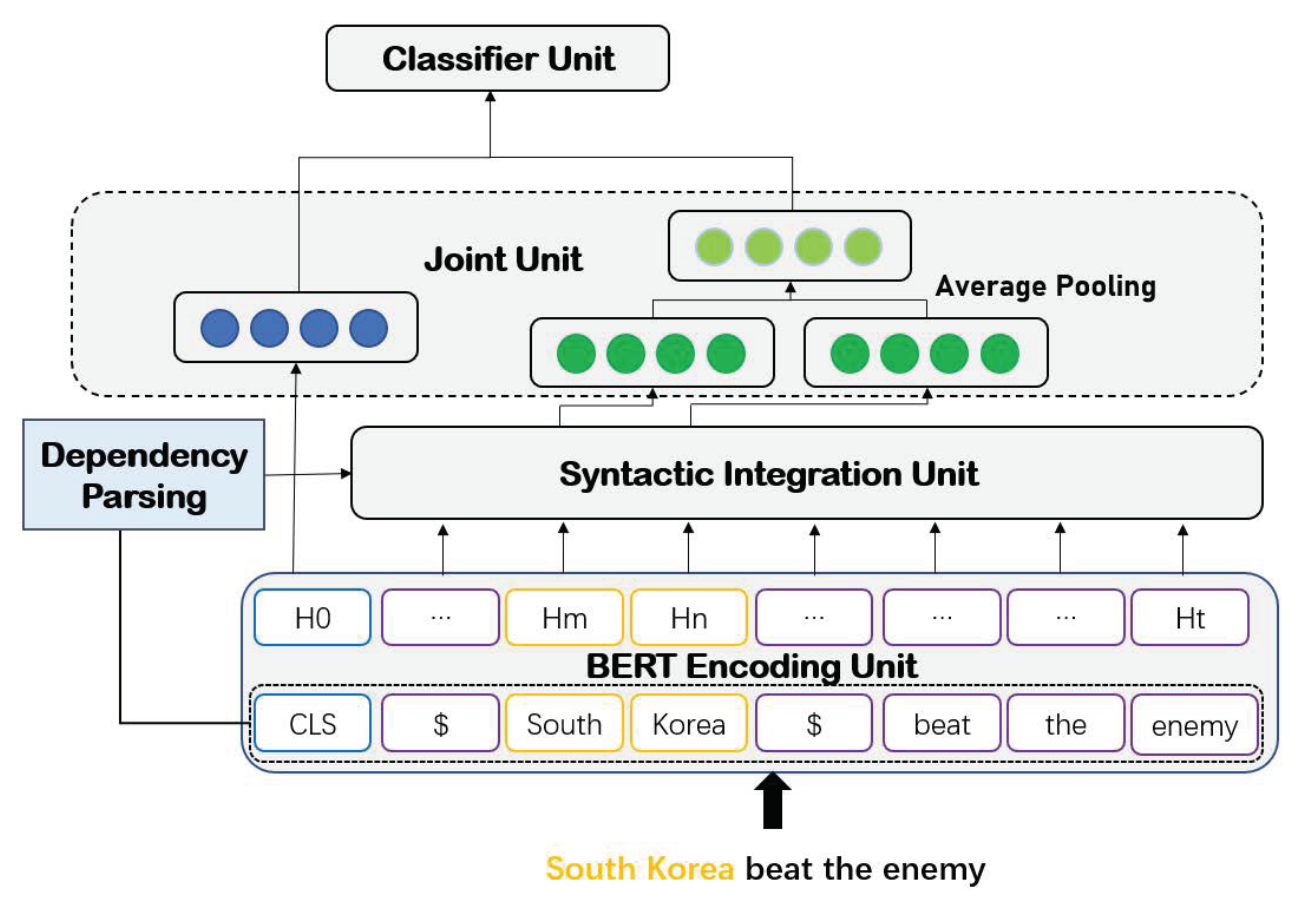
Figure 2. Model architecture. Better representation for the entity nominal “South Korea” is obtained based on the pre-trained language representation from the BERT unit by integrating the syntactic constraints using a soft dependency-based